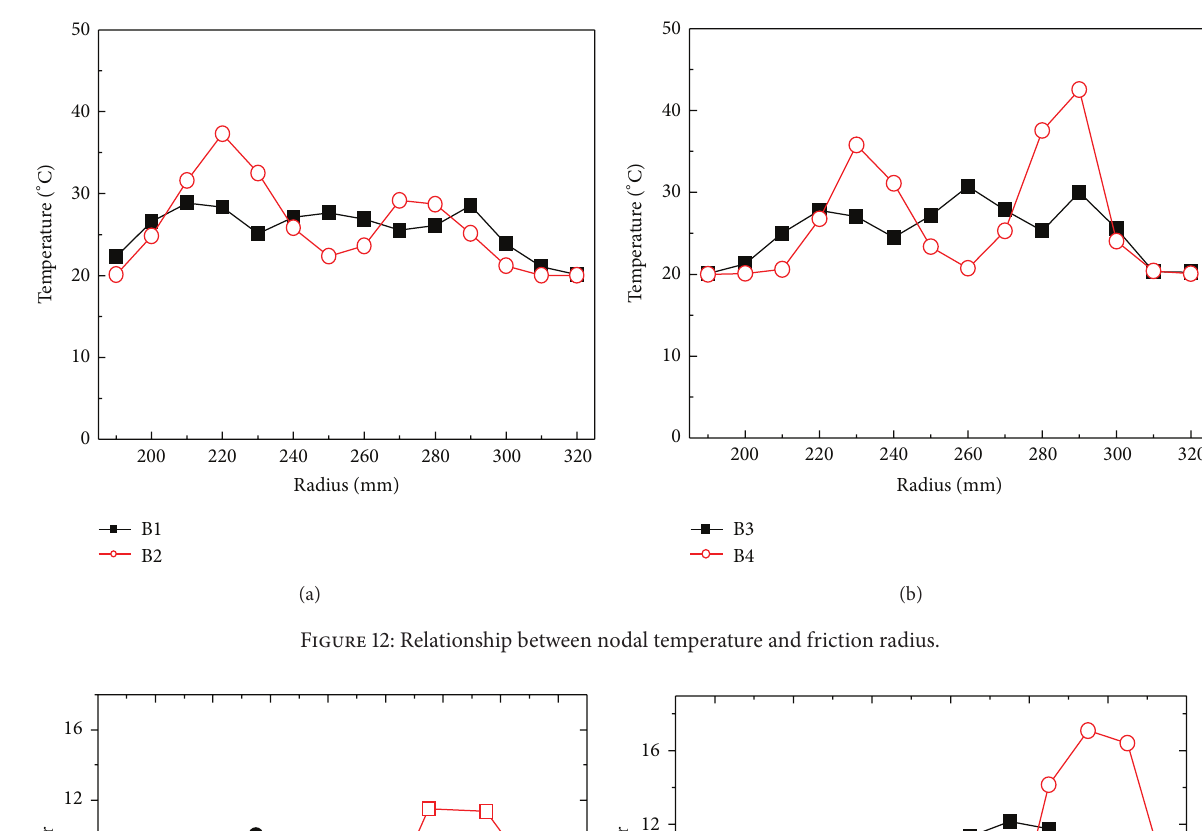
Figure 11: Nodal temperature distribution on brake disc.